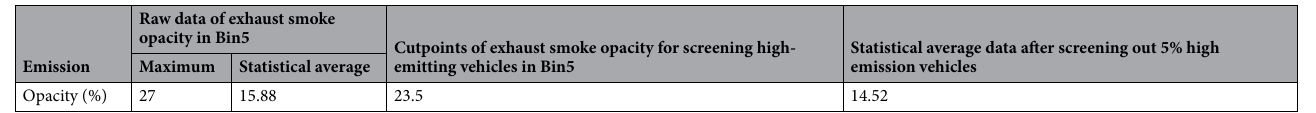
Raw data of exhaust smoke opacity in Emission